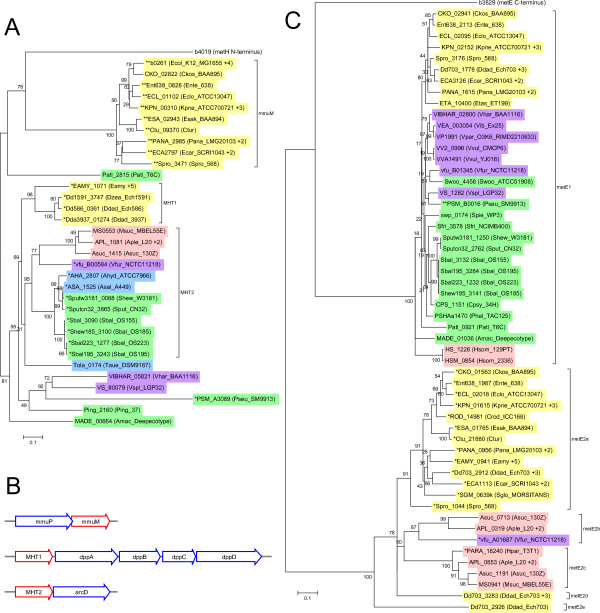
Genes containing methionine synthase domains. (A) Members of the MHT superfamily. Proteins were aligned with the first ~350 residues of E. coli metH which contains the MHT domain. (B) mmuM, MHT1 and MHT2 (in red) occur in clusters with transporters mmuP, dppABCD and arcD (in blue) respectively. (C) Members of the CIMS-C-terminal-like family. Proteins were aligned with the C-terminal half of E. coli metE which is the more conserved half. Genes have been collapsed by genus and are indicated by the species abbreviation of one representative member of the genus. The number in parentheses afterwards indicates the number of species which were excluded. Species color-coding is as described in Figure 2. Genes with metboxes are in bold and marked with an asterisk.